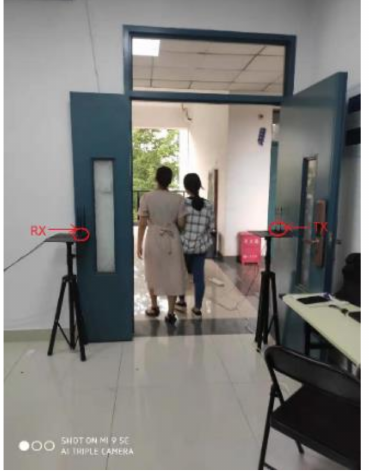
Figure 10. Participants walking through the